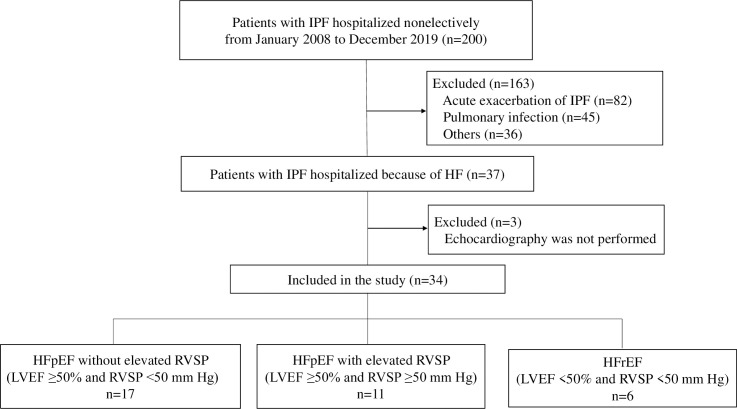
Flowchart of the enrollment of study patients.HF, heart failure; HFpEF, heart failure with preserved ejection fraction; HFrEF, heart failure with reduced ejection fraction; IPF, idiopathic pulmonary fibrosis; LVEF, left ventricular ejection fraction; RVSP, right ventricular systolic pressure.